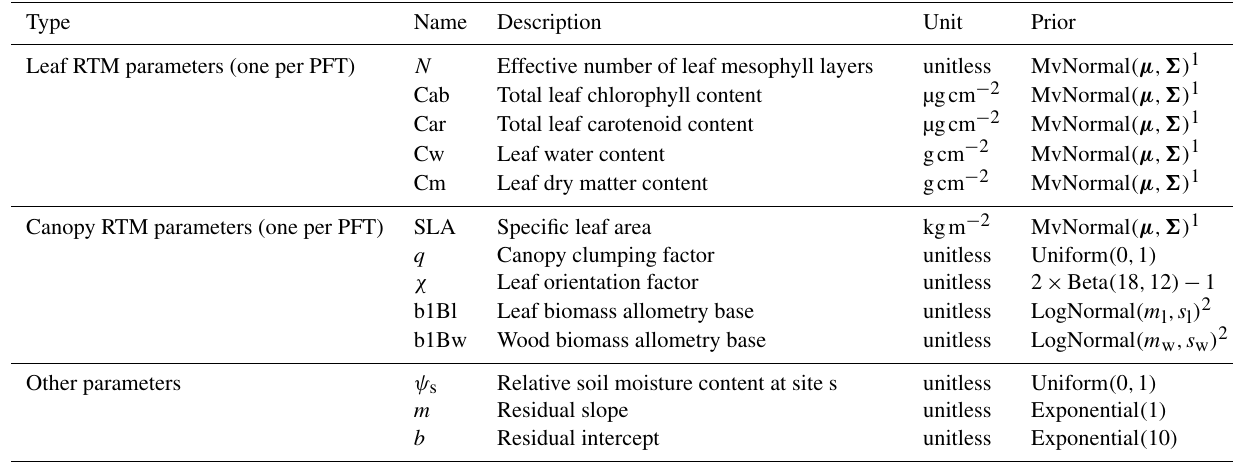
Table 1. EDR parameters and prior distributions.